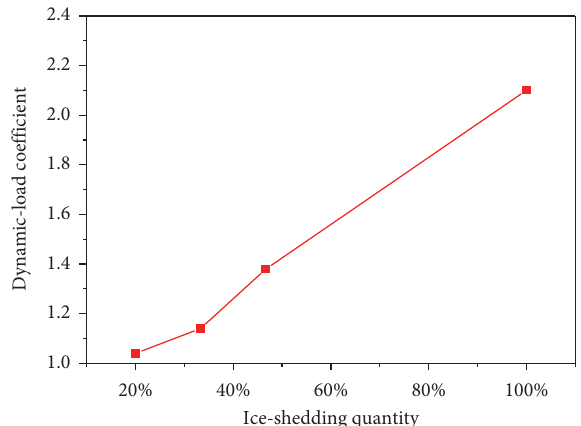
Figure 10: The variation of the dynamic-load coefficient with ice- shedding quantity.